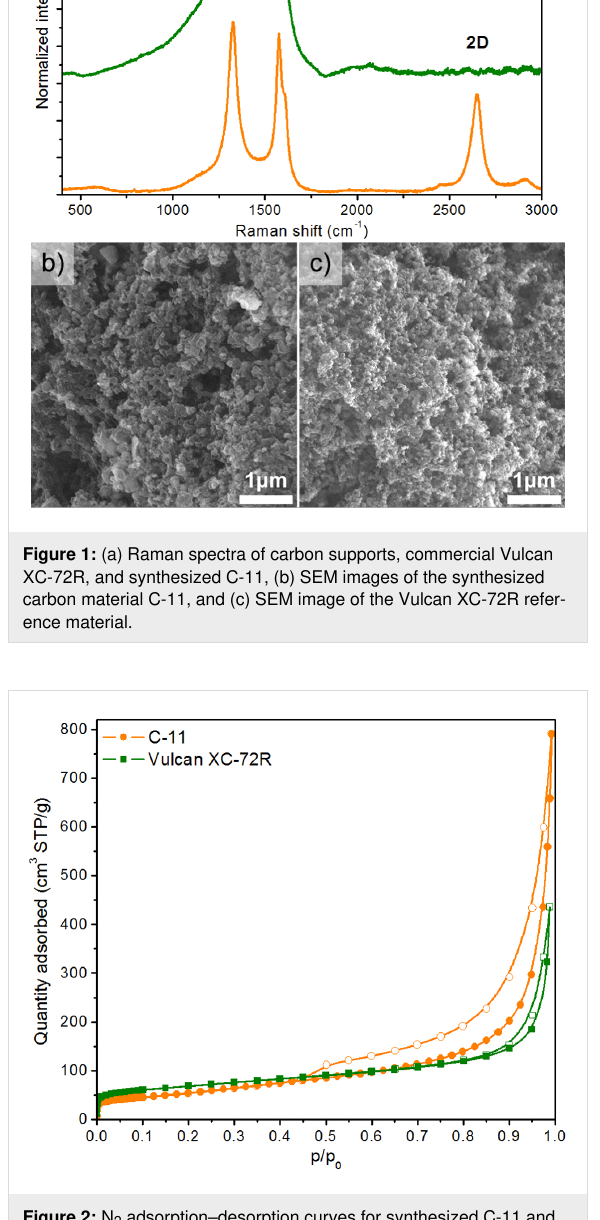
less developed mesoporosity than C-11. C-11 has depleted microporosity but more developed mesoporosity, i.e., a wider hysteresis loop and a higher isotherm with p / p 0 values approaching 1. Both isotherms (i.e., of XC-72R and C-11) can be classified as type II (according to IUPAC classification [39]) but with H3-type hysteresis loops. A sharp increase of N